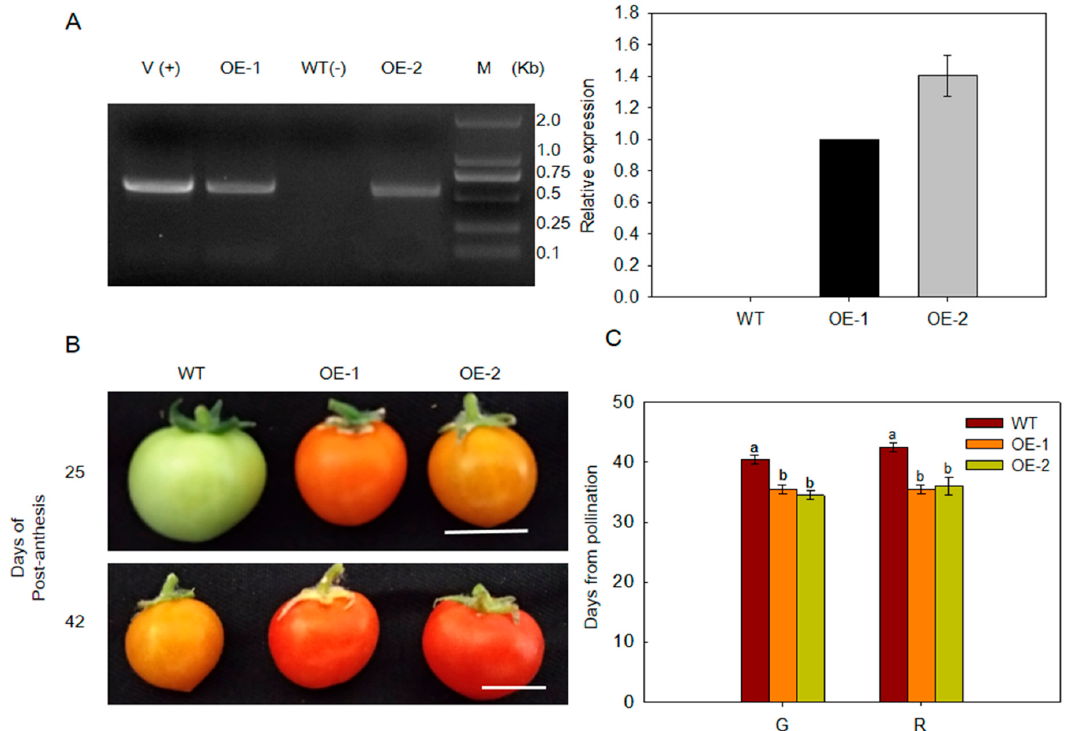
Figure 3. ( A ) PCR confirmation for transgenic tomato plants. Left panel: PCR with DNA; lanes: M, molecular marker DL2000; V( + ), positive vector containing pCambia2300- MdARD4 plasmid; WT( − ), non-transformed wild type; OE-1 and OE-2, MdARD4 transgenic tomato lines; Right panel: Quantitative RT-PCR analysis of MdARD4 expression in leaves of WT and MdARD4 transgenic lines OE-1 and OE-2, the expression level of MdARD4 in line OE-1 was set as 1; ( B ) phenotype comparisons between WT and MdARD4 transgenic fruits. Bar, 2 cm; and ( C ) days from pollination to green (G) and red (R) stages. Data are means of three replicates with SD. Di ff erent letters indicate significant di ff erences between WT and MdARD4 transgenic plants on the same day of di ff erent treatments, according to one-way ANOVA Tukey’s multiple range tests ( p <